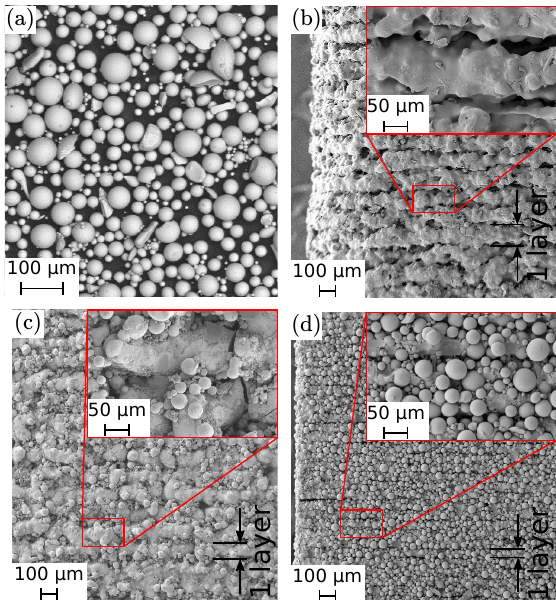
Figure 2. All presented AM methods use the same isotropic NdFeB powder (MQP-S-11-9, Magnequench). ( a ) scanning electron microscope (SEM) image of the initial MQP-S powder. SEM images of the surfaces of magnetic samples, printed with: ( b ) FFF, ( c ) SLS, ( d ) SLA. Volumetric mass density (cid:36) is measured with with a hydrostatic balance (Mettler Toledo, AG204DR) based on the Archimedes principle. The filling fraction of the MQP-S powder inside the polymer matrix for the FFF and the SLA printed samples is measured with by loss on ignition (LOI), whereby the sample is heated up to 1100 ◦ C [24] (Table 1). All measurements are performed with three different samples to minimize the statistical error. The density for the FFF sample is around 20% lower compared to the theoretical value ( (cid:36) = 4.35 g/cm 3 ). SLS shows a density that is in the